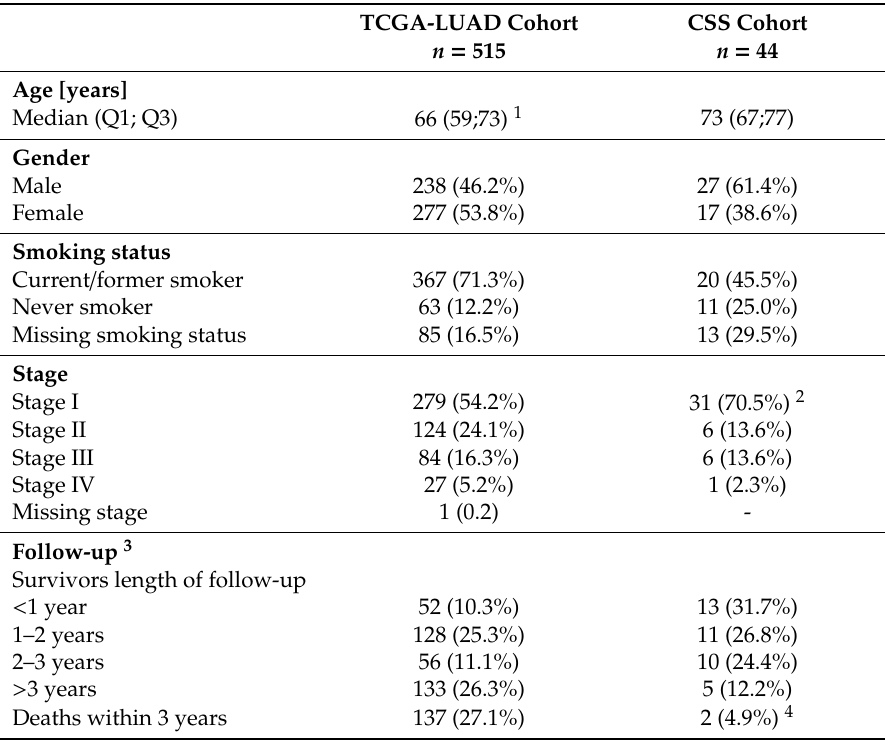
Table 1. Patients and tumors